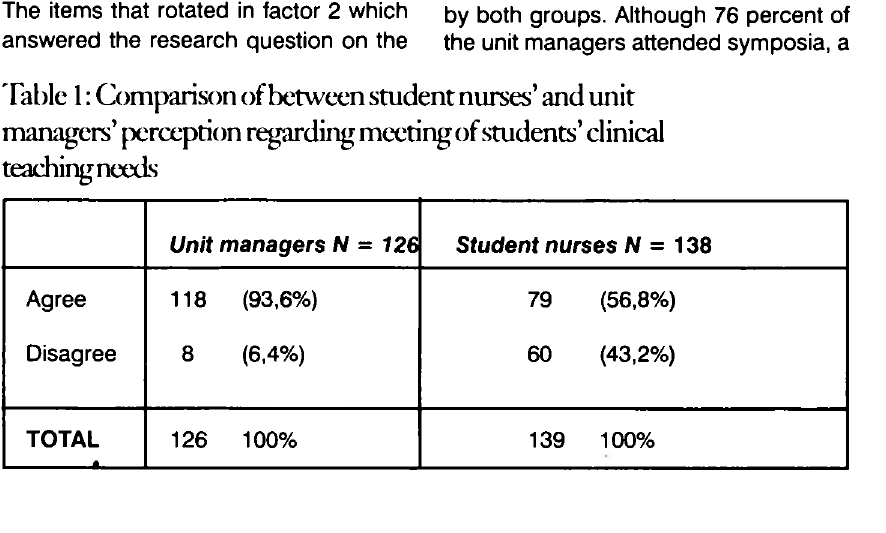
Table 1: G)mparison of between student nurses’ and